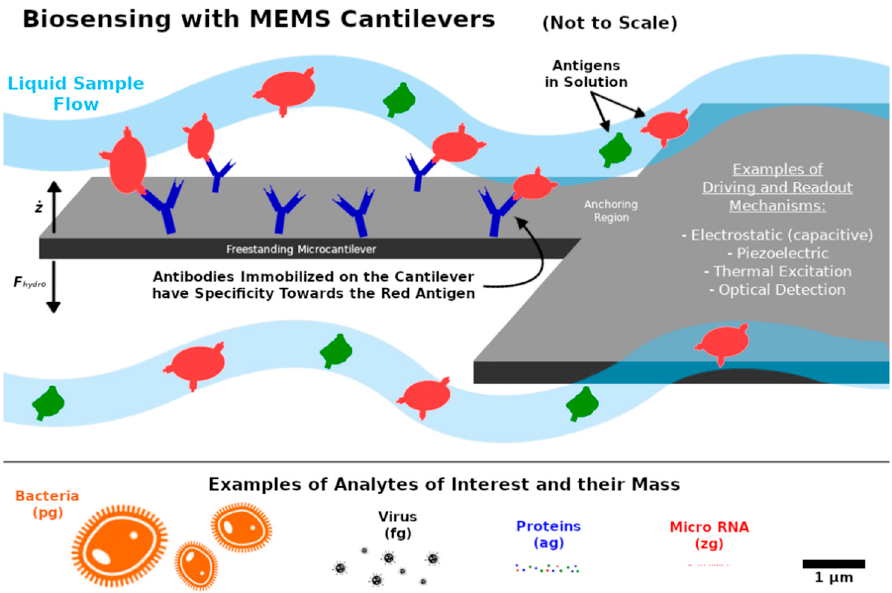
Figure 6. Illustration of a biosensing strategy with a microcantilever. The cantilever is functionalized with antibodies on the top surface (these are the biorecognition agents, which are chemically bound to the surface). Due to the specific binding of analytes (in this simple example, the red antigens are captured by the antibodies but the green ones are not), a resonance frequency shift or a static deflection will occur. On the bottom, the scale of the size and mass of bacteria, virus particles, proteins, and micro RNA strands is illustrated.